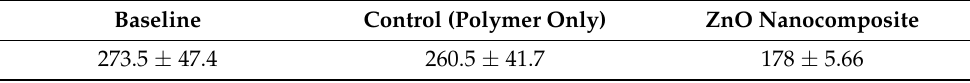
Table 3. C. difficile colony counting.